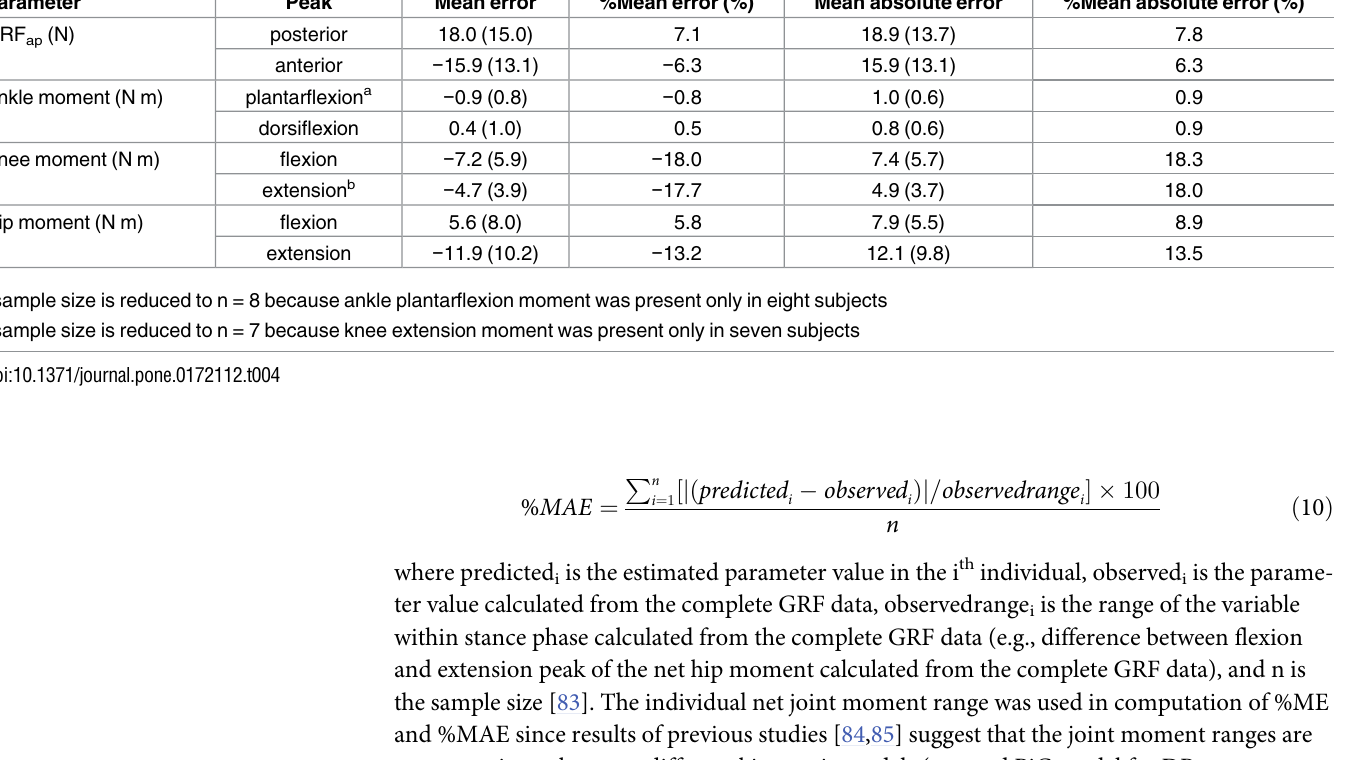
Table 4. Errors of estimatesof the peak GRF ap and peak net joint moments (mean (SD)).